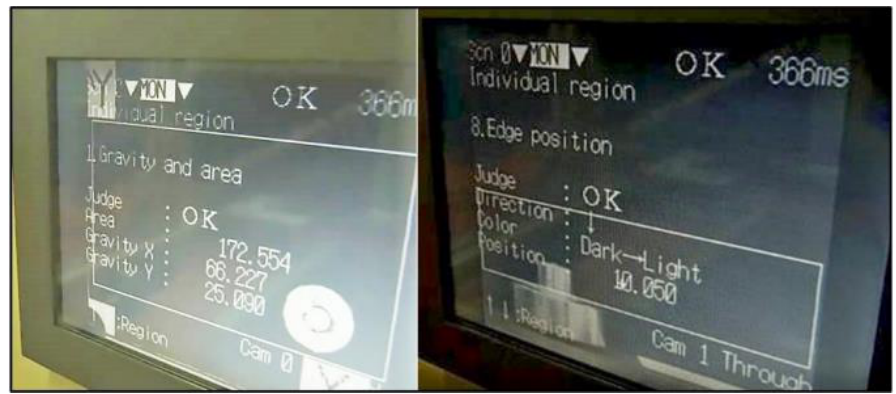
Figure 8. Determination of the object’s coordinates.